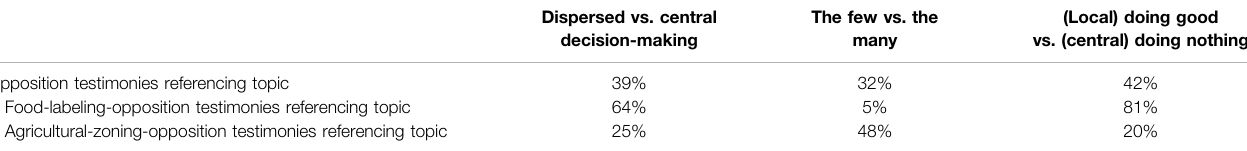
TABLE 3 | Relative use of topoi, opposing state